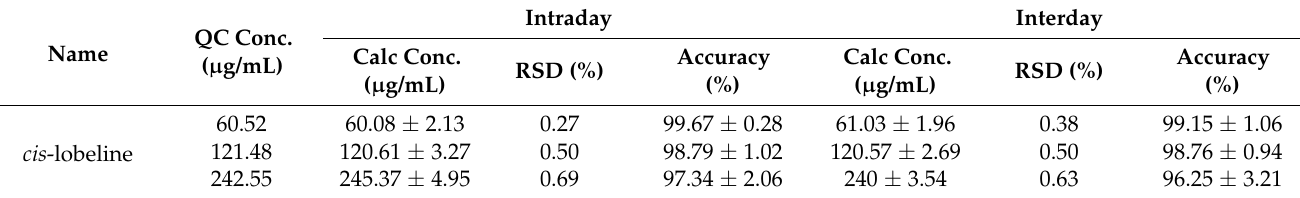
Table 4. Intra-/interday accuracy and precision of the developed assay ( n = 6).